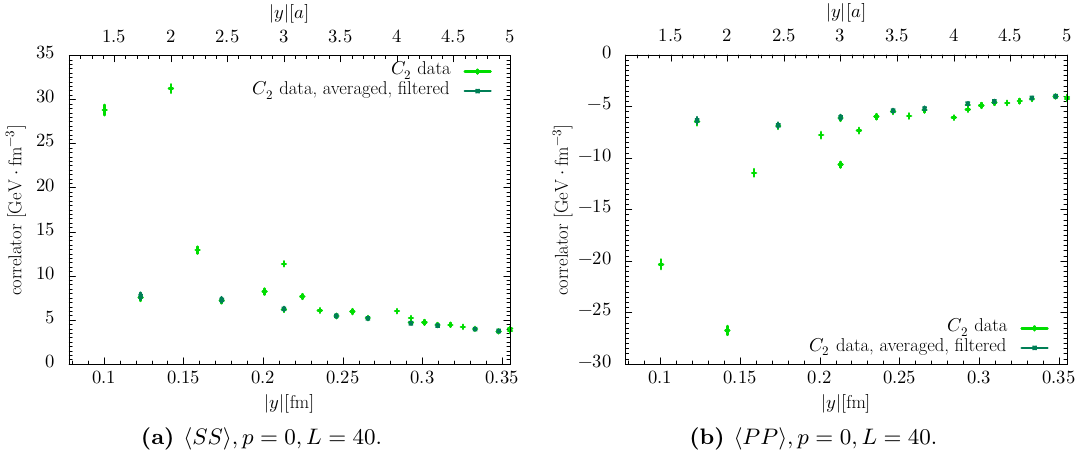
Figure 7. Anisotropy e(cid:11)ects for the contraction C 2 at small y (light points) and their removal by the cut (4.2) (dark